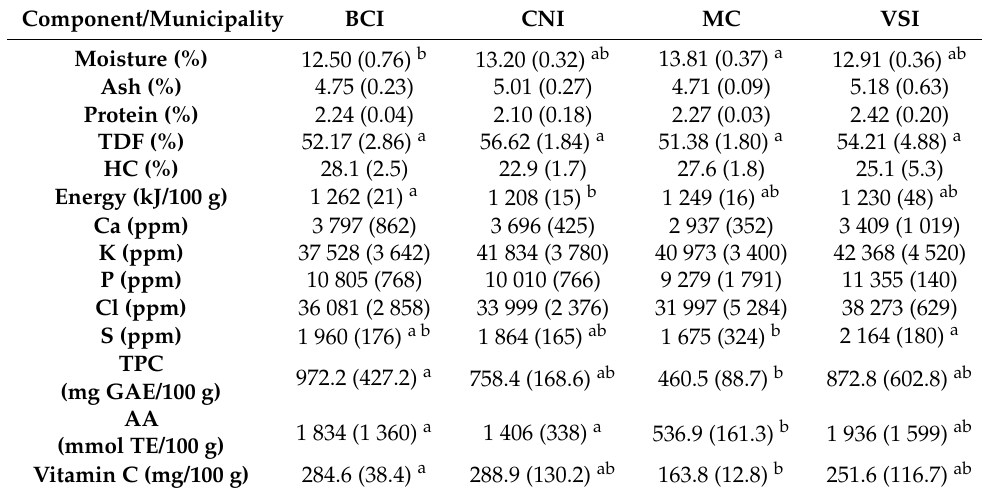
Table 1. Means and standard deviation (within brackets) of the different baobab’s constituents across the four Namibe municipalities and collected samples, and results from the pairwise tests on the equality of means of the constituents across the four municipalities (Equation (2)—Tukey, Dunnet-Tukey-Kramer and Dunn tests) for the constituents for which the existence of at least one pairwise significant difference was detected (Equation (1)—F-ANOVA, F-Welch-ANOVA and Kruskal– Wallis tests).